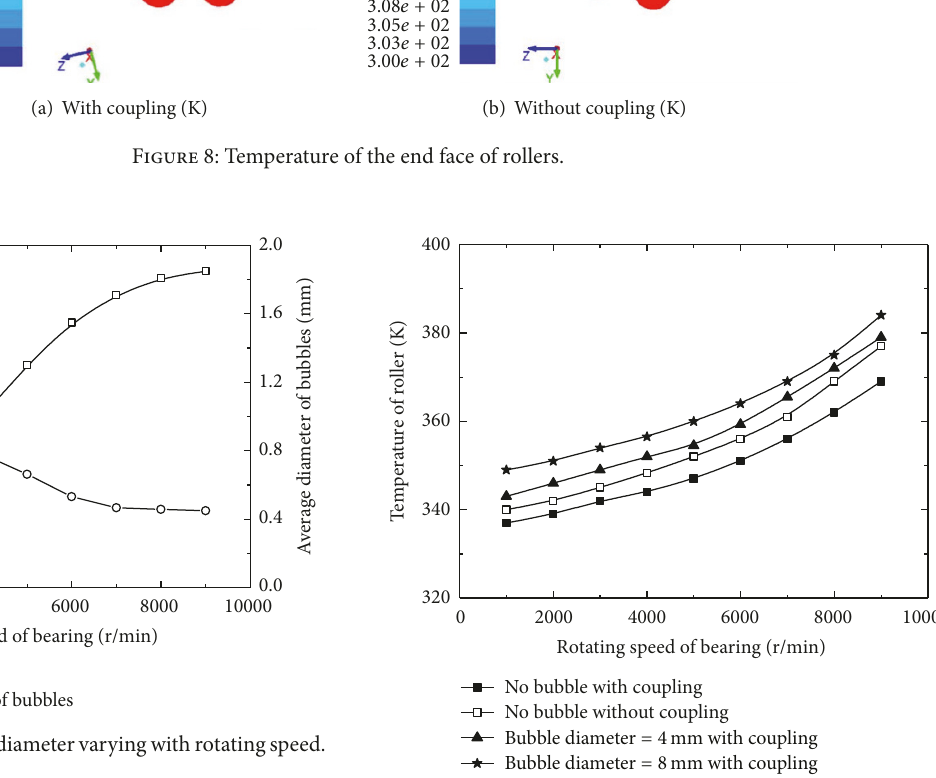
Figure 10: Effect of diameter of bubbles on temperature of